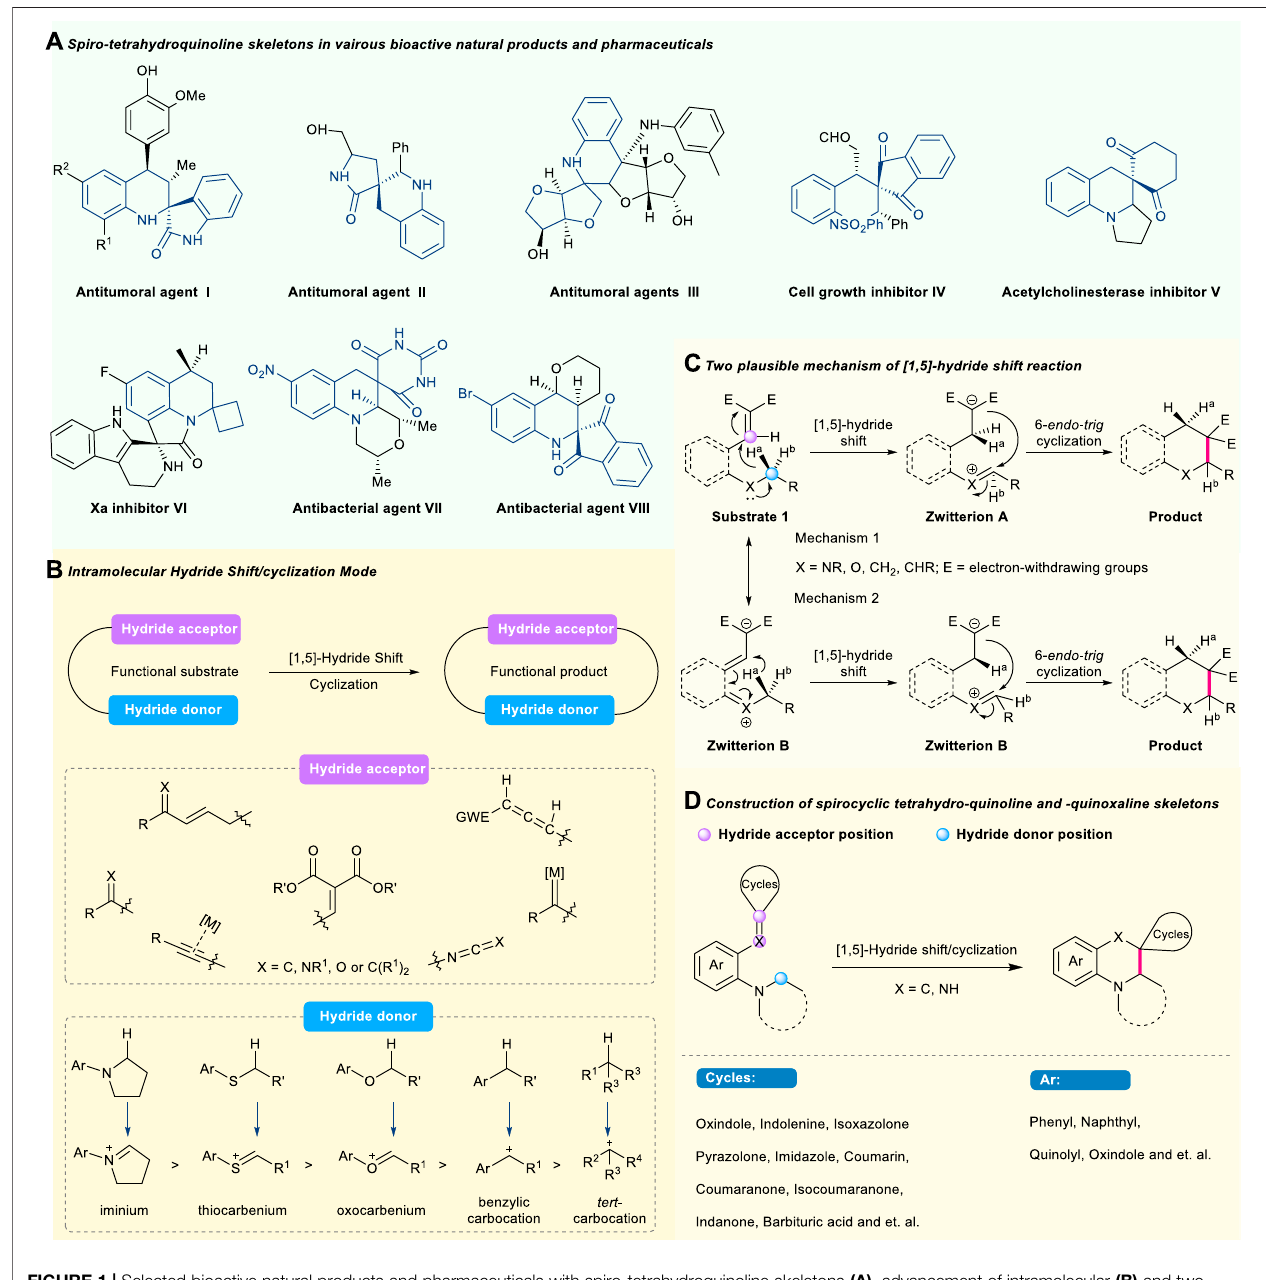
FIGURE 1 | Selected bioactive natural products and pharmaceuticals with spiro-tetrahydroquinoline skeletons (A) , advancement of intramolecular (B) and two plausible mechanisms (C) of [1,5]-hydride shift mode, and construction of spiro-tetrahydroquinoline framework (D) .